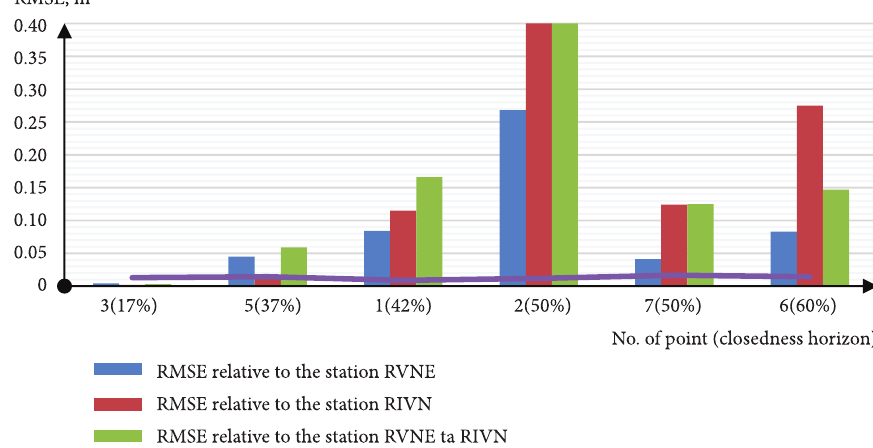
Figure 2. Comparison of RMSE of the height location by the session duration for 1 hour without executing the preliminary planning and prognostic points of accuracy evaluation calculated by Equation